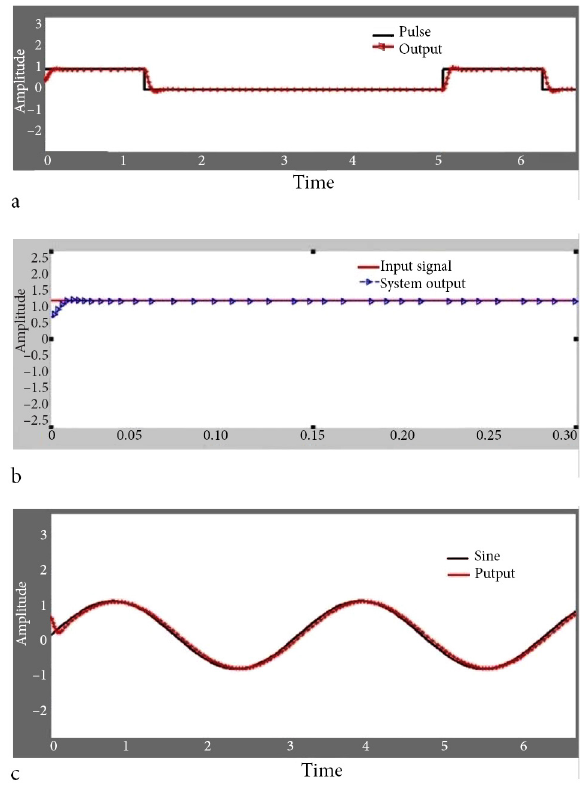
Fig. 9. Responses: a) response of the system to a pulse signal; b) response of the system to a step signal; c) response of the system to a sine